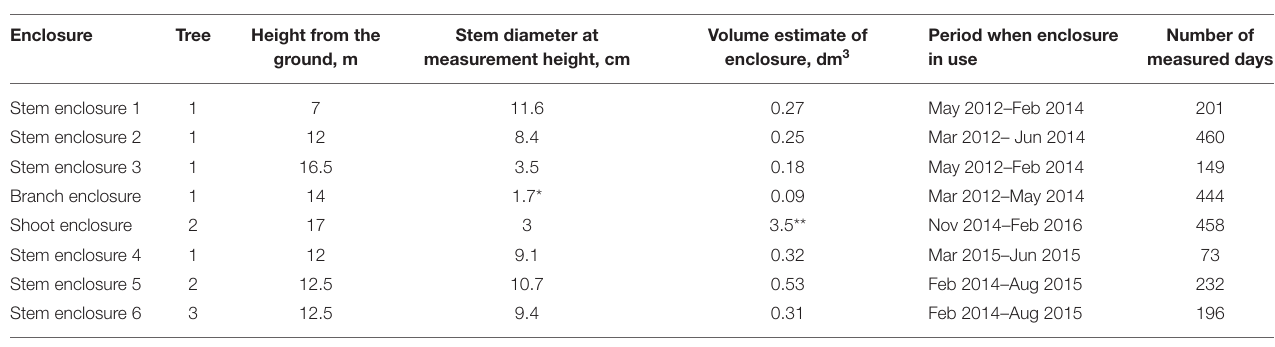
TABLE 1 | The measurement enclosure